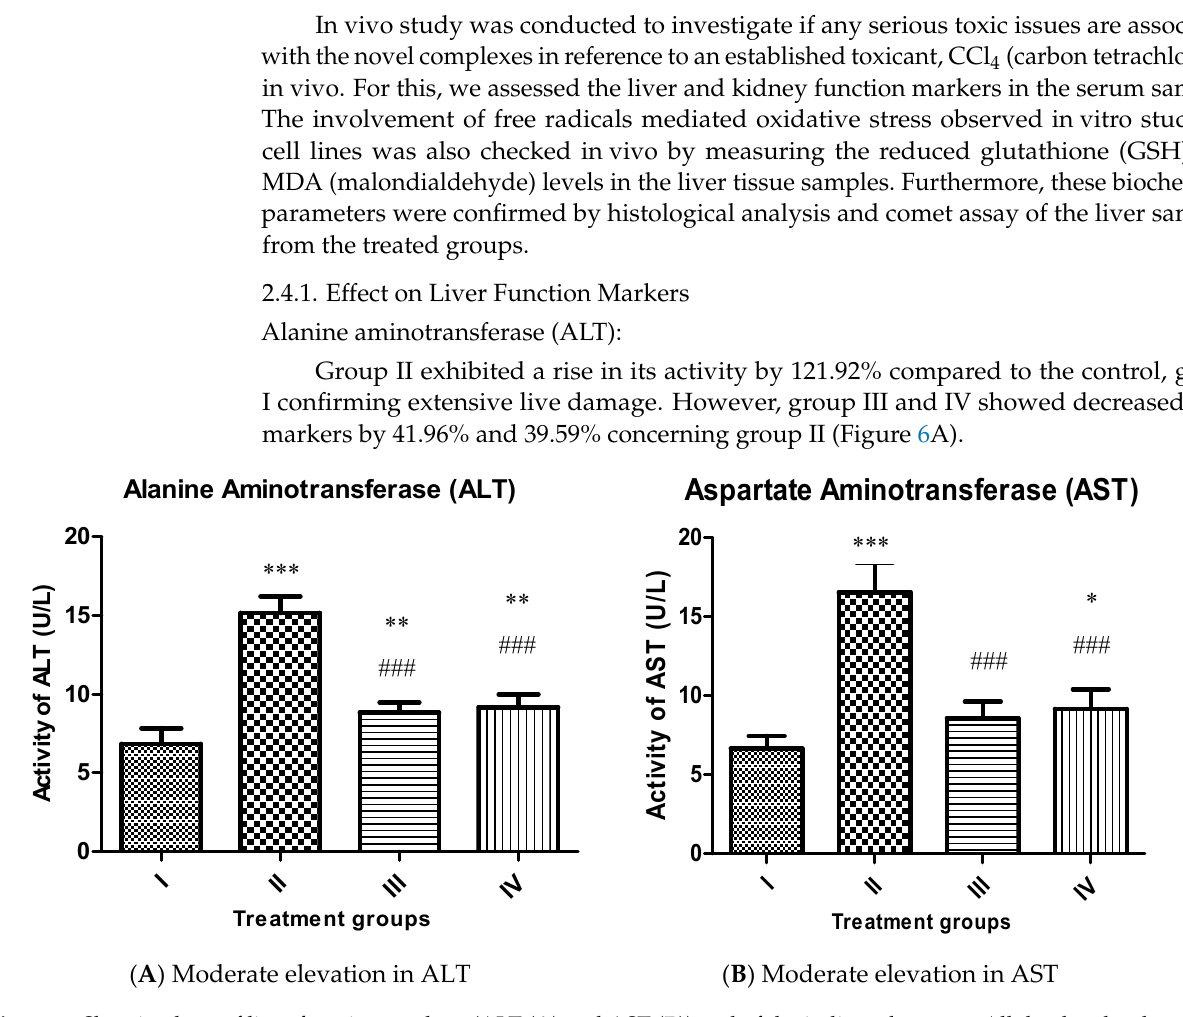
Figure 6. Showing bars of liver function markers (ALT ( A ) and AST ( B )) and of the indicated groups. All the data has been expressed in mean ± SEM for each group. * indicates statistically different from the control (group I) at p ≤ 0.05 while # indicates statistically different control positive (group II). Also ** and ## indicate p ≤ 0.005 while *** and ### indicate p ≤ 0.001.